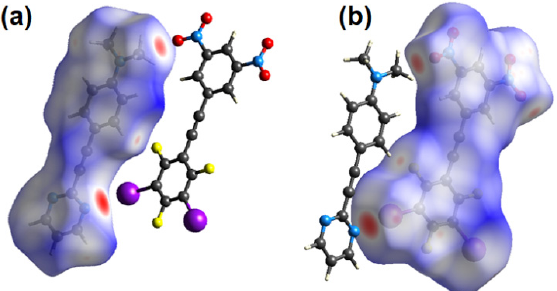
Figure 10. Asymmetric unit of the cocrystal 2•3 with displacement ellipsoids drawn at the 50% level. Halogen bonds and tetrel bonds shown as dashed lines.